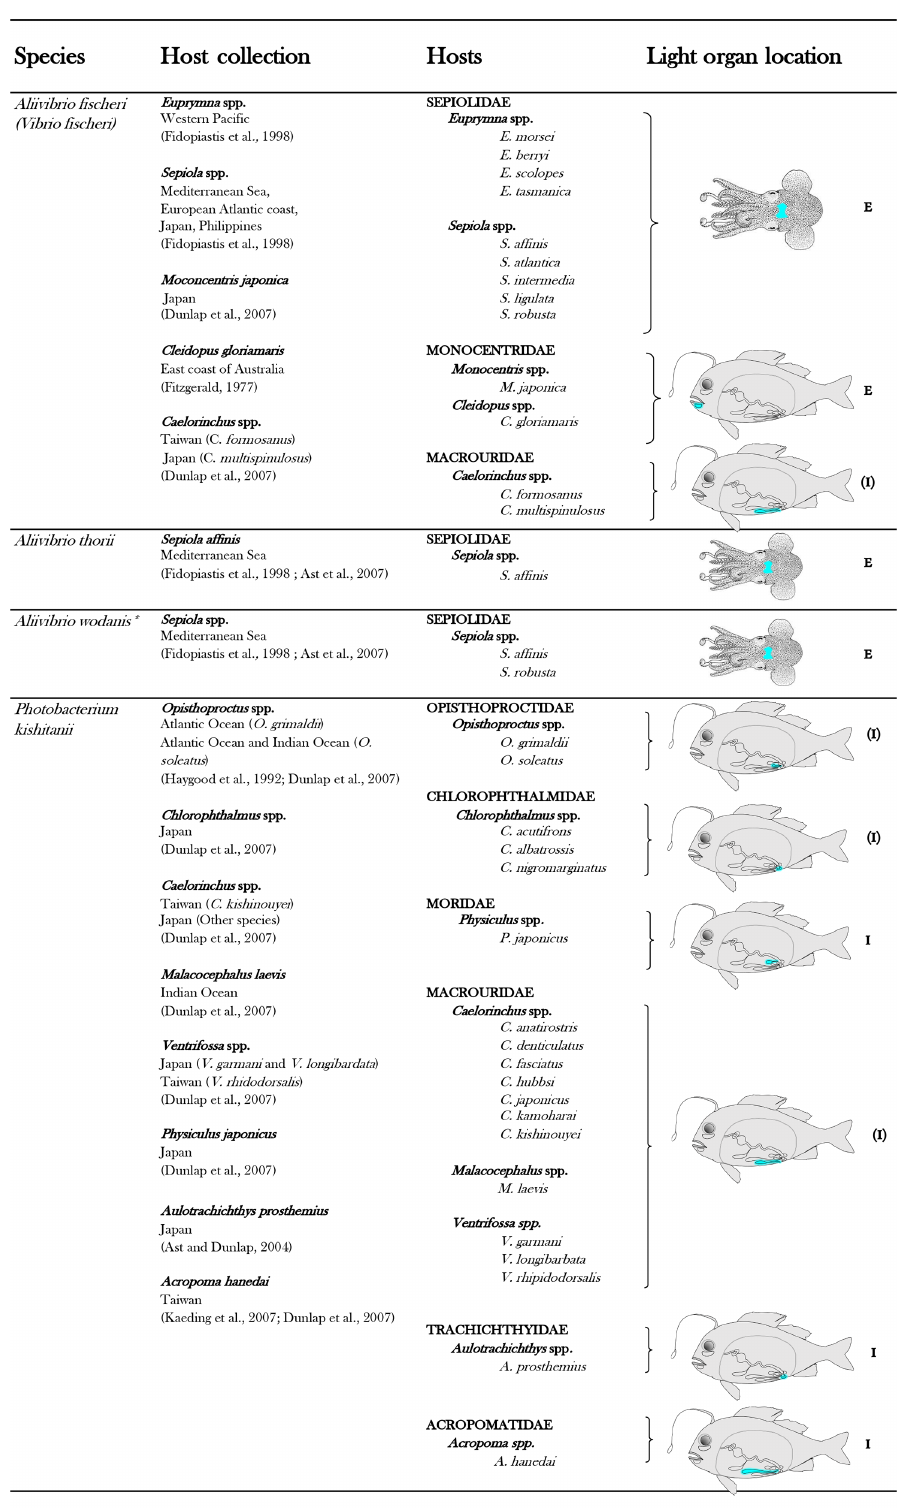
Table 1. List of luminous bacterial species found in light organ symbiosis in fishes and squids. The diagrammatic fish, from Nealson and Hastings (1979), was used to indicate, in blue, the approximate locations of the light organ of the different families of symbiotically luminous fishes. E indicates an external expulsion of the bioluminescent bacteria, directly into the seawater. I indicates an internal expulsion of the bioluminescent bacteria, in the digestive tract. ( E ) or ( I ) indicate a putative localization of the